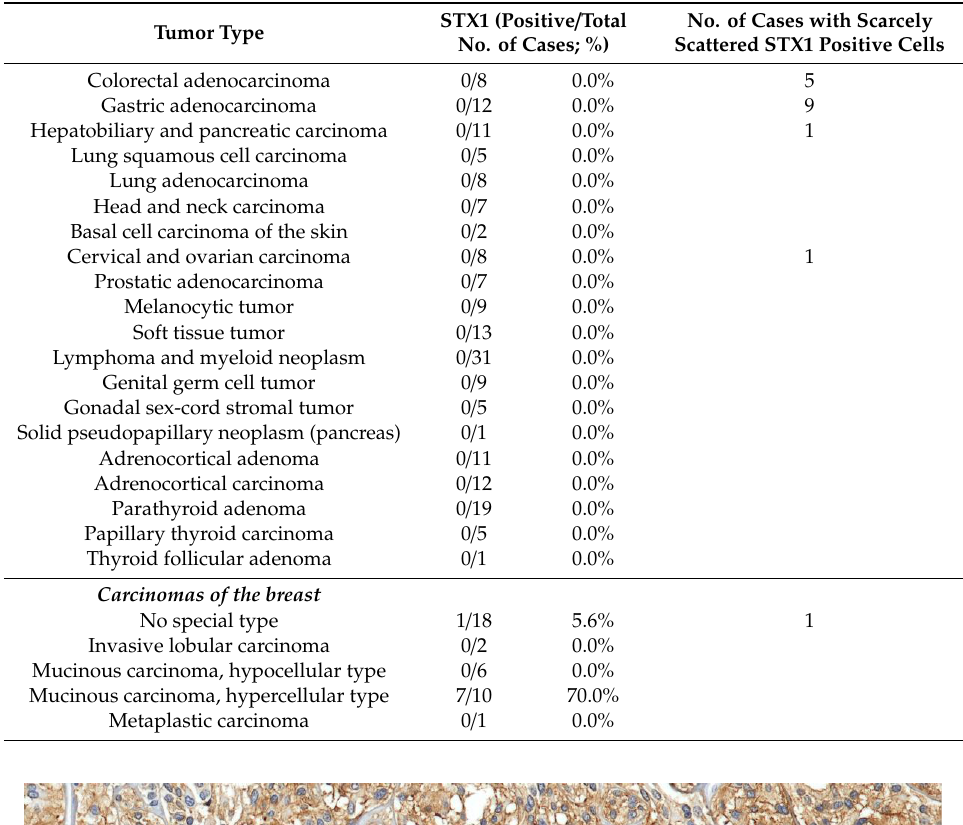
Table 3. STX1 immunoreactivity in conventional (non-NE) tumors.